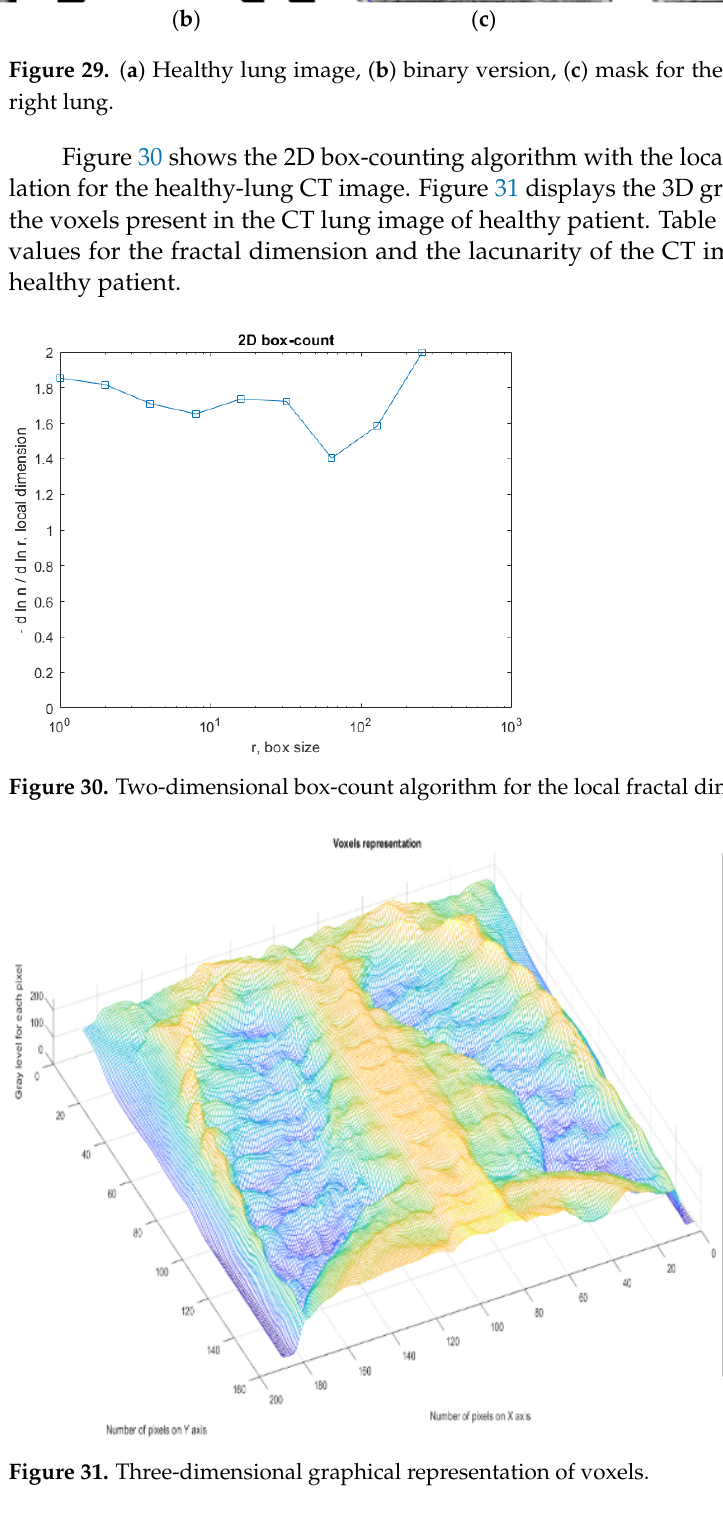
Table 7. Calculation of fractal indicators for the healthy lung patient (HLP) .